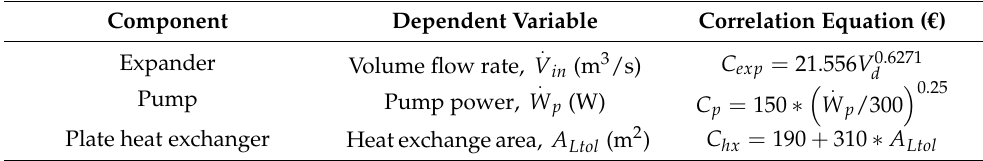
Table 8. Cost correlations for the main components of ORC